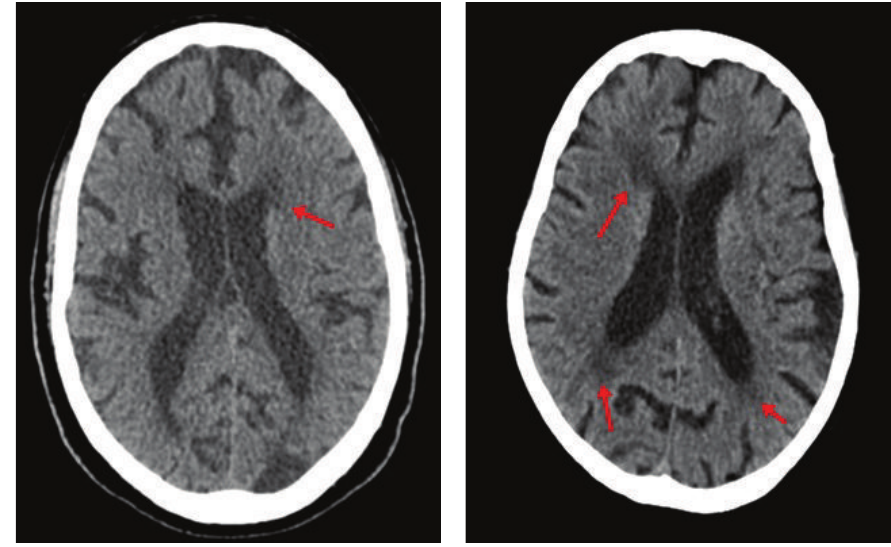
Figure 1: Two examples illustrating degrees of LA in CT